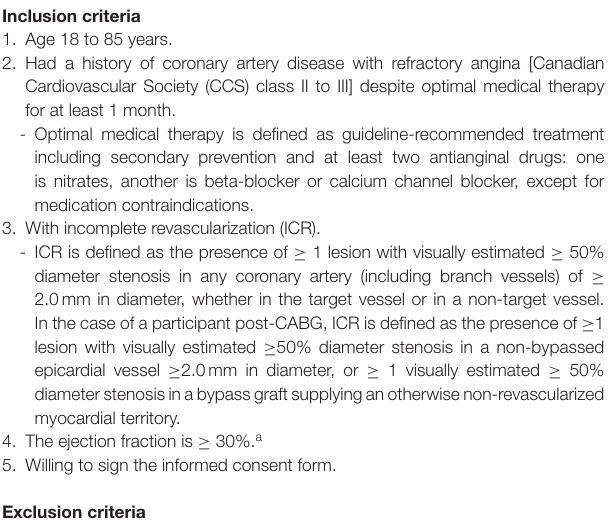
TABLE 1 | Eligibility criteria. Inclusion criteria 1. Age 18 to 85